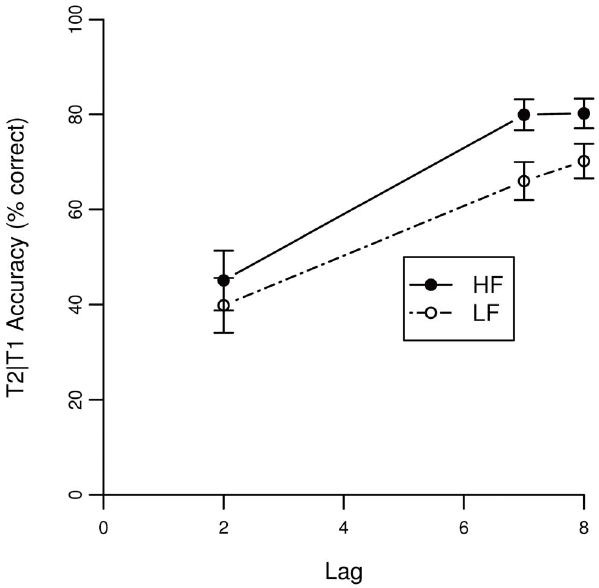
Figure 7. Accuracy scores of the AB task on lag 1, 2 and 7 for T2 given T1 correct in Experiment 2. The lag corresponds to the temporal location of T2 relative to T1.